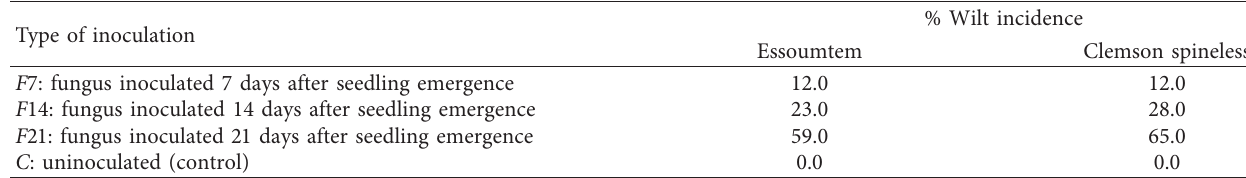
Table 9: Percentage wilt incidence for “essoumten” and “clemson spineless” under various inoculations in field experiment. Type of inoculation